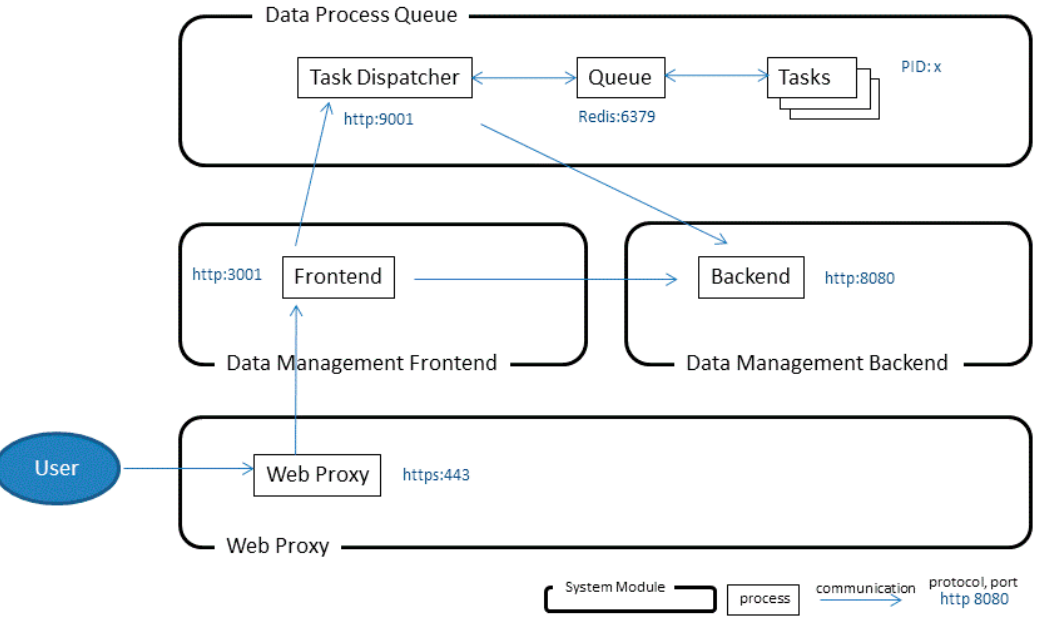
Figure 3. Visualisation of a typical user workflow and application for aggregation of inhomogeneous datasets in the context of system stack interaction.